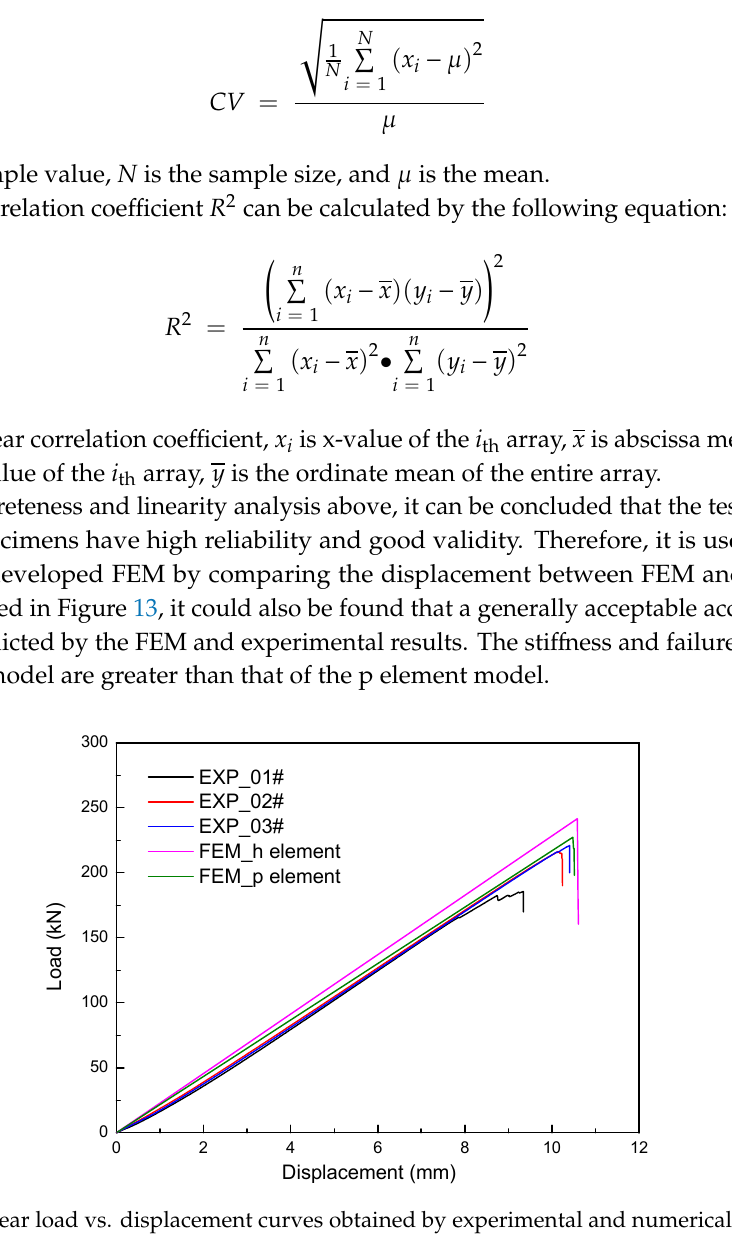
Figure 14. Load vs. displacement curves linear fitting and regular residual value curves. From the discreteness and linearity analysis above, it can be concluded that the test data obtained from the three specimens have high reliability and good validity. Therefore, it is used to verify the feasibility of the developed FEM by comparing the displacement between FEM and experimental results. As presented in Figure 13, it could also be found that a generally acceptable accuracy is shown for the results predicted by the FEM and experimental results. The stiffness and failure load predicted by the h element model are greater than that of the p element model. 6.2. Strain Analysis 6.2.1. Strain Data The strain data obtained from the gauges at the shear field of each test panel are shown in Figure 15. These curves show a good linearity response before shear failure, and the linearity is greater than 0.998. The orientations of strain gauge (SG) 4th–6th and 104th–106th on the top and